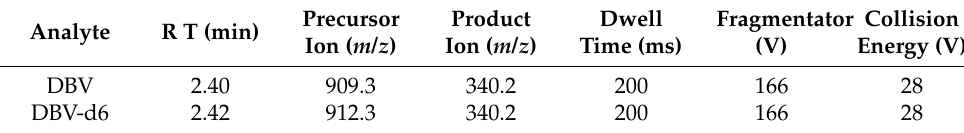
Table 2. Specific MRM transition parameters used for DBV and for DBV-d6 acquisition (RT = retention